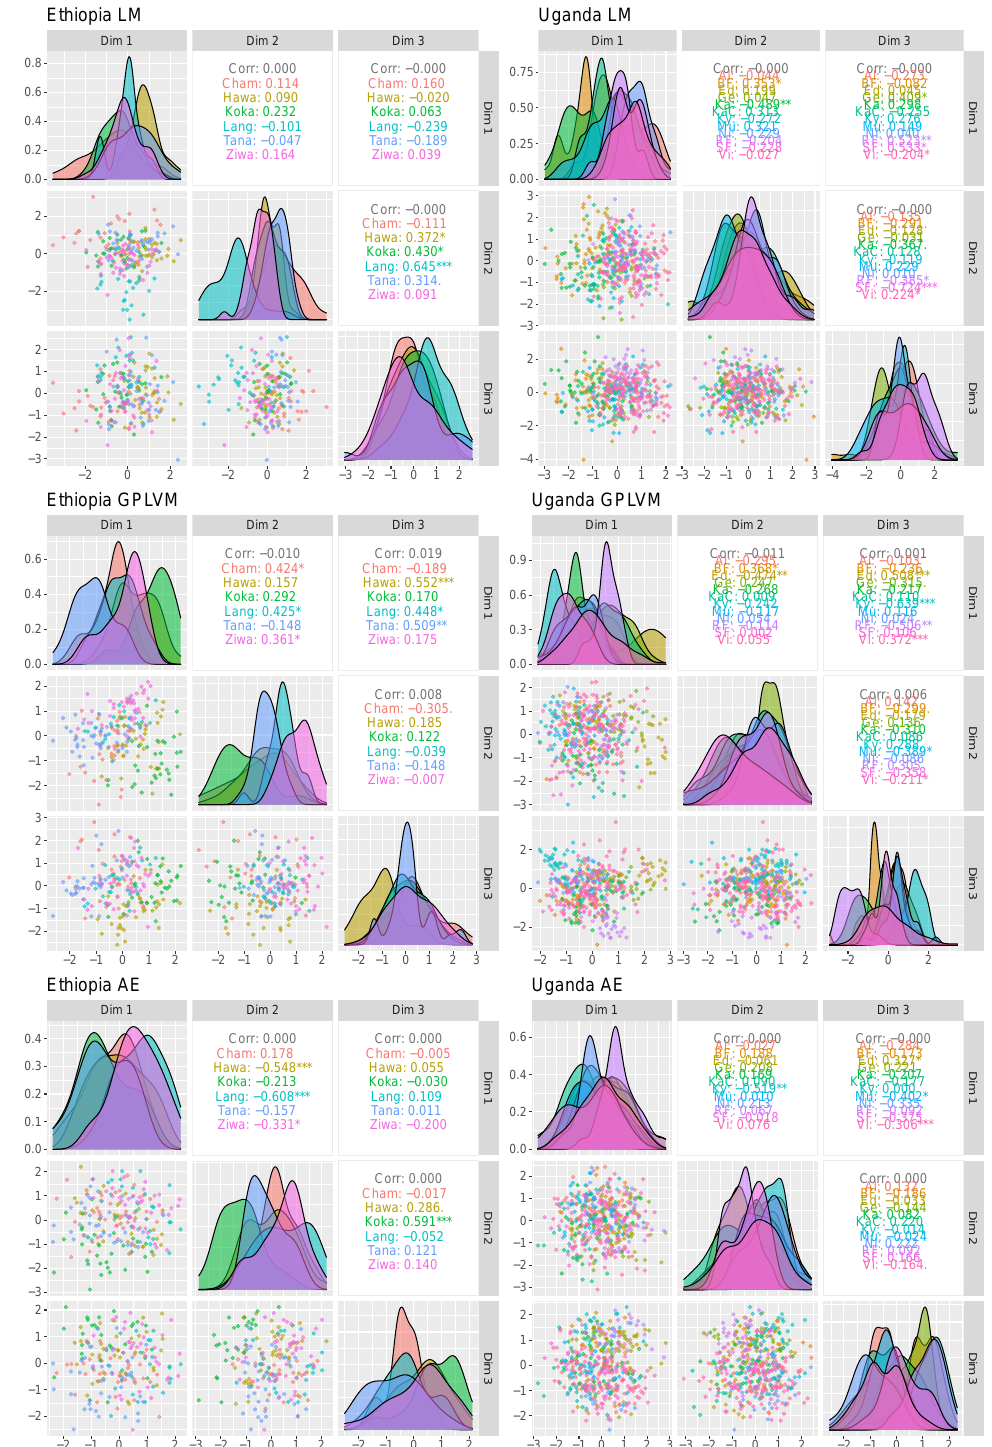
Figure 12. Visualization of the multivariate analysis of Ethiopia ( left column ) and Uganda ( right column ). The figures show the PCA/ICA reduced landmarks ( top ), GP-LVM features ( middle ) as well as reduced cAE features ( bottom ). The symbols ‘***’, ‘**’, ‘*’ as well as ‘.’ next to the numeric correlation values indicates significant levels below 0.001, 0.01, 0.05 and 0.1. If no symbol is given, the significance level was obtained to be larger than